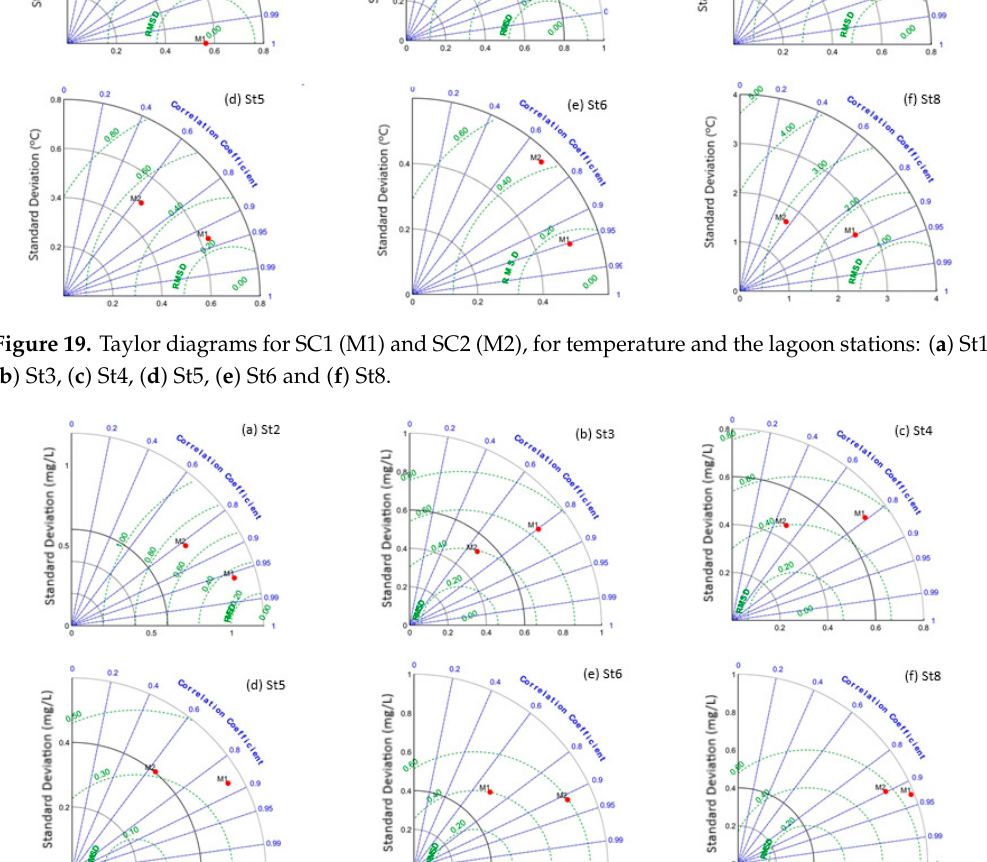
Figure 21. Taylor diagrams for SC1 (M1) and SC2 (M2), for carbon phytoplankton, PC, and the lagoon stations: ( a ) St1, ( b ) St3, ( c ) St4, ( d ) St5, ( e ) St6 and ( f ) St8). 5. Discussion This study aims to assess the Ria de Aveiro physical and biogeochemical status, under future climate scenarios, considering the impact of climate changes in the lagoon coastal area, namely the rise of the sea level and of the amplitude of the M 2 component of the tide, the changes of the river discharges, and the rising of the air temperature. It used a coupled physical and eutrophication model that simulates the main state variables of the water column. The baseline scenario (BS) showed that the salinity patterns of the lagoon are mainly influenced by the exchange with the ocean waters. Even under mean rivers discharge the salinity distributions for the late summer evidenced that the ocean water influence reaches the lagoon upper areas, where high values of salinity (~34 PSU) are observed, as well as important gradients of